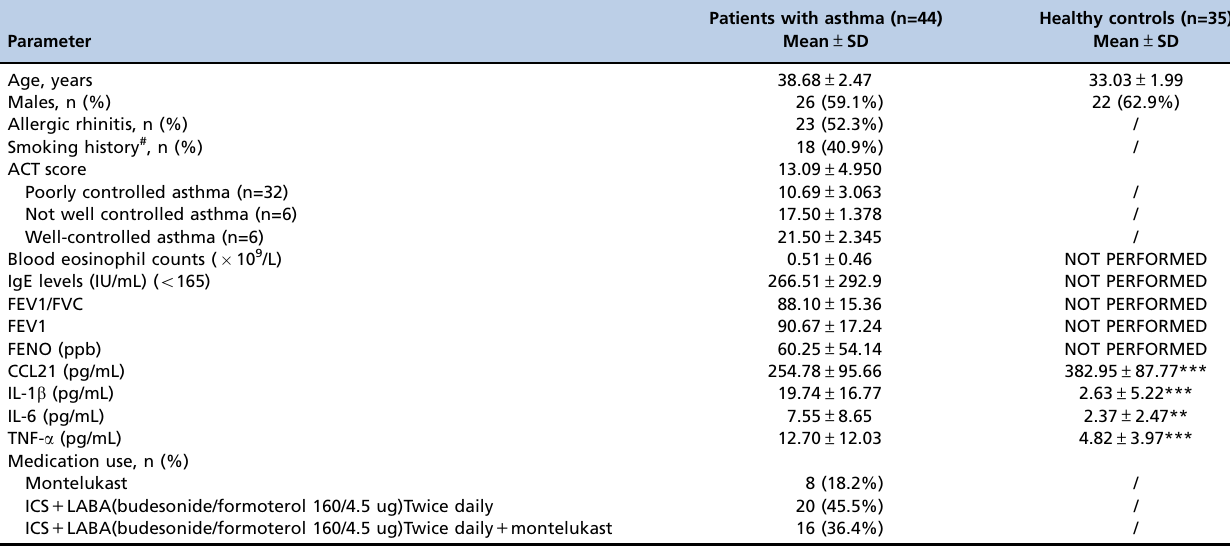
Table 1 - Clinical characteristics of the participants included in the study.